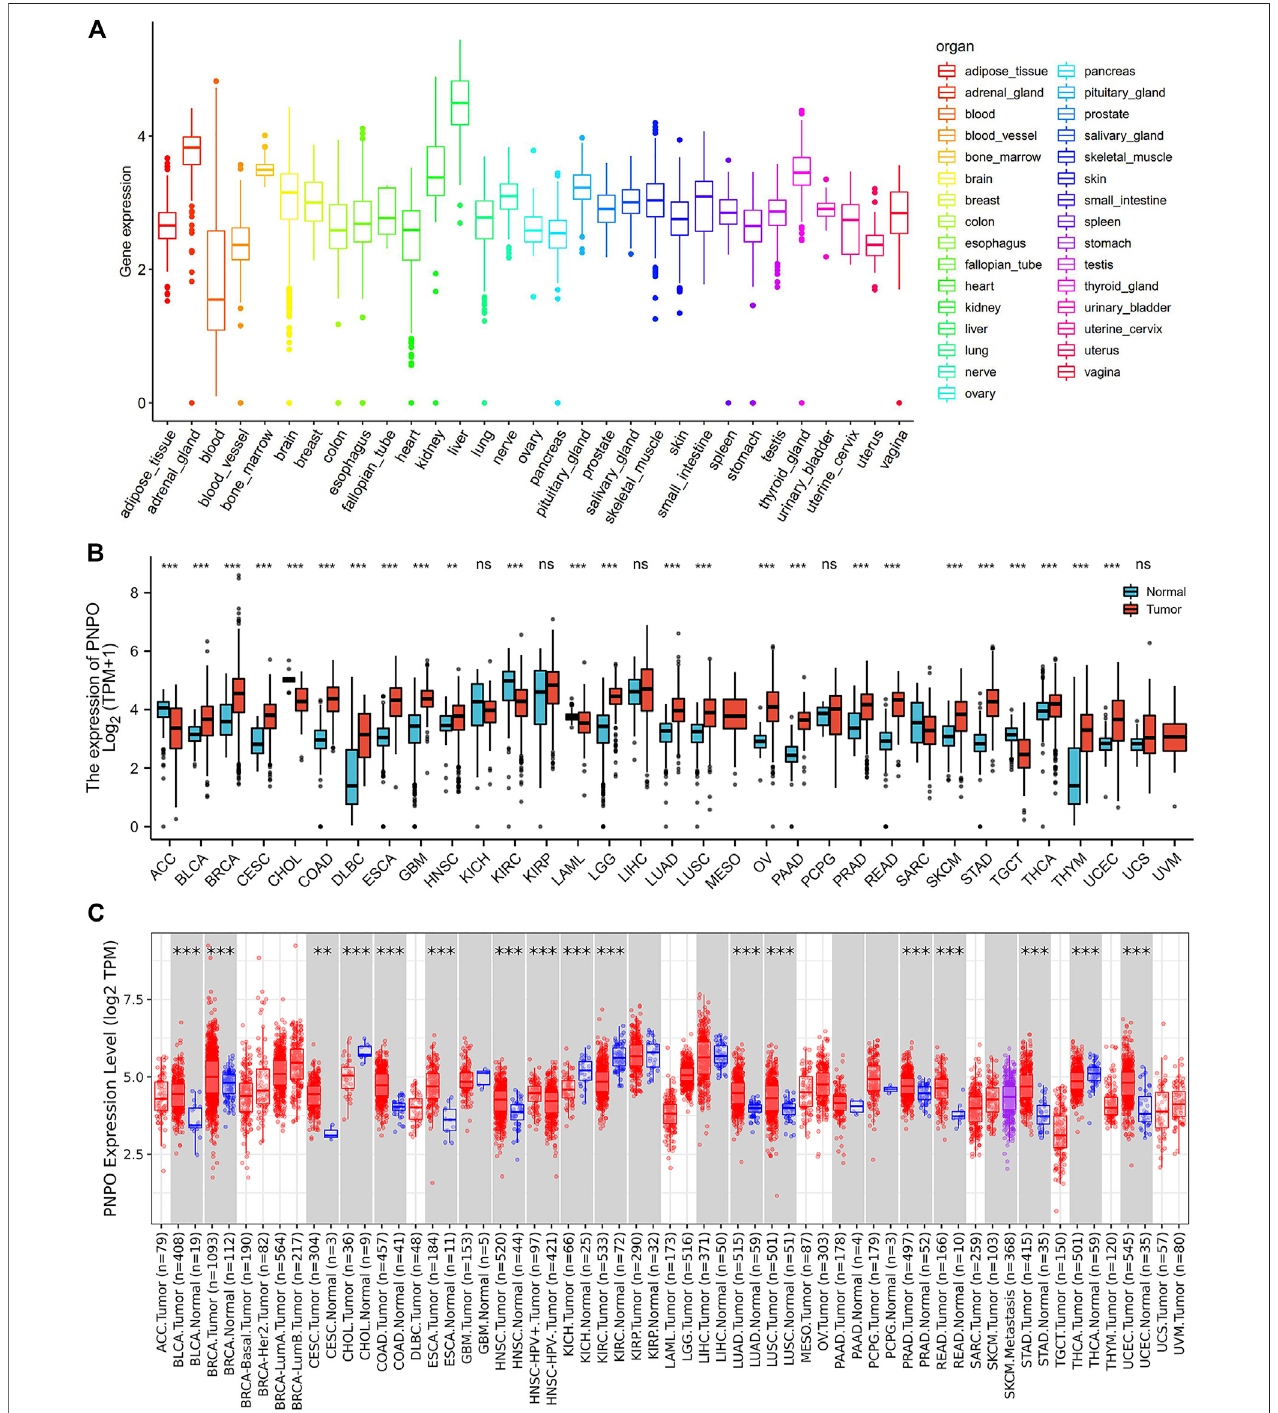
FIGURE 1 | Differential expression of PNPO. (A) PNPO mRNA expression in normal tissues from GTEX data. (B) Differential PNPO mRNA expression between TCGAcancersandGTEXnormaltissues.Theredcolumnrepresentscancersamplesandthebluecolumnrepresentsnormalsamples.Normalgroupwasnormaltissue inTCGAandGTEXdatabase. (C) PNPOmRNAexpressionindifferentcancertypesinTIMER.* p < 0.05,** p < 0.01,and*** p < 0.001.Normalgroupwasnormaltissuein TCGA database.